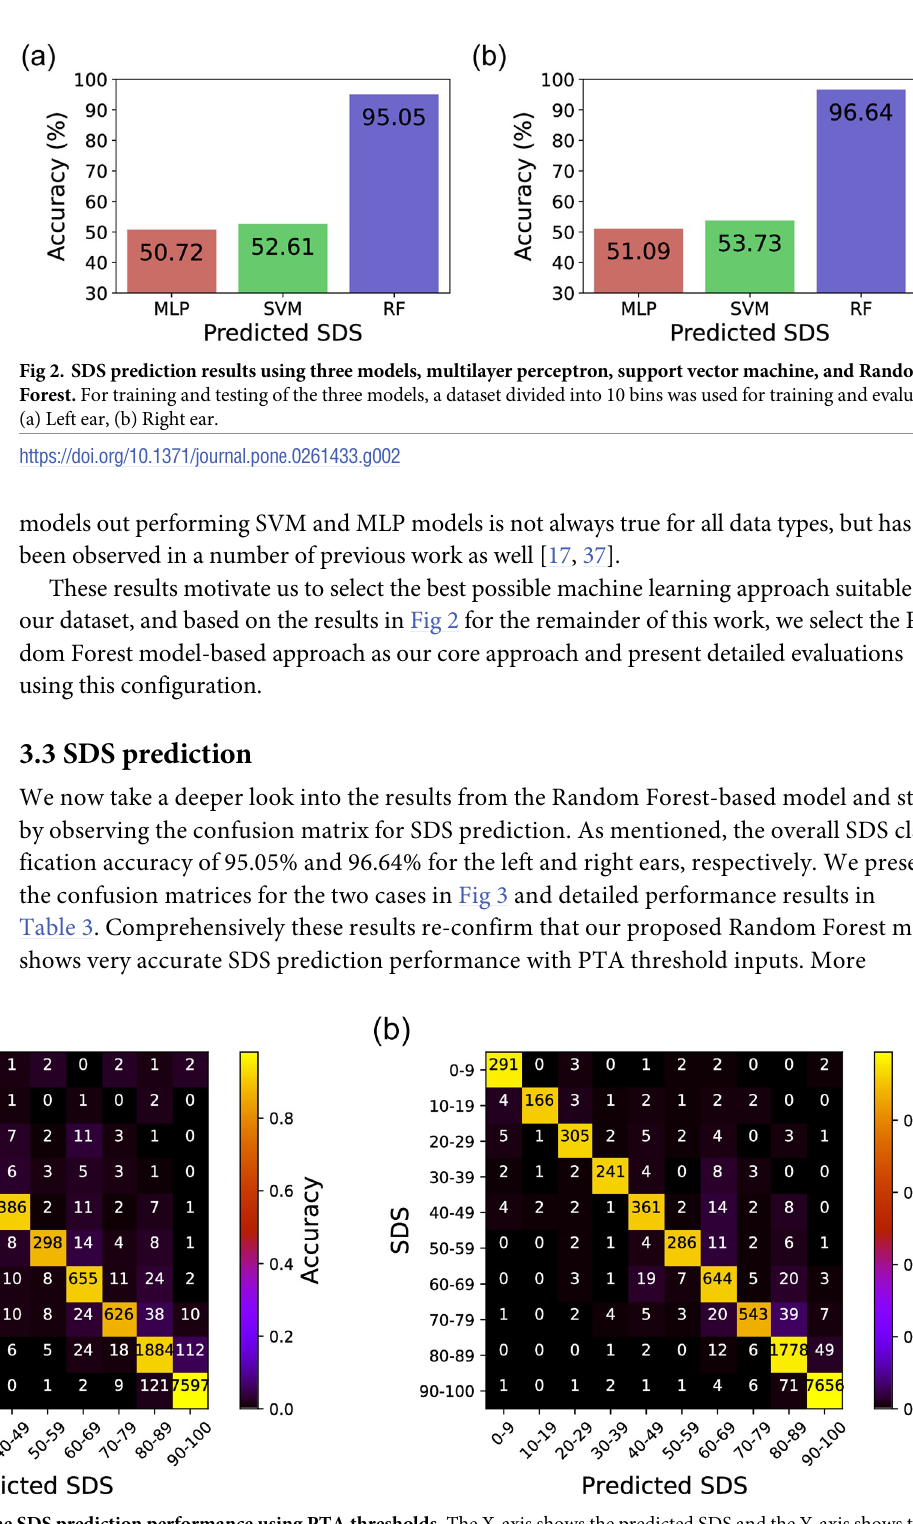
Fig 3. Confusion matrix for the SDS prediction performance using PTA thresholds. The X-axis shows the predicted SDS and the Y-axis shows the ground-truth. The numbers in the matrix present the number of prediction occurrences. An ideal confusion matrix would have bright colors (high occurrence counts) diagonally. (a) Left ear, (b) Right